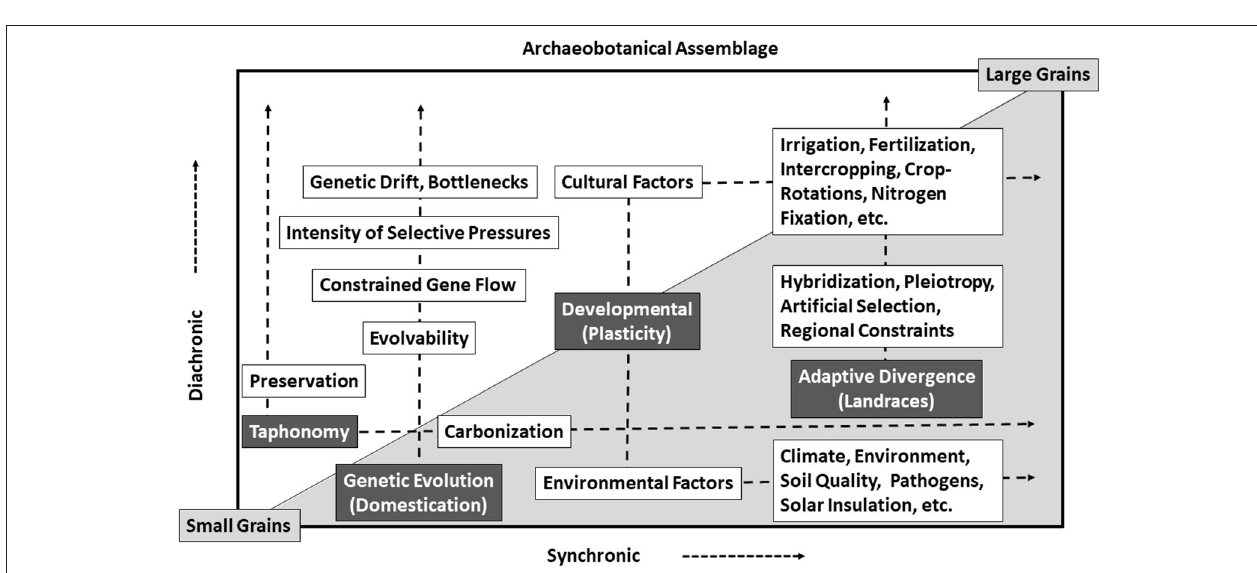
FIGURE 7 | Factors driving cereal grain size change though